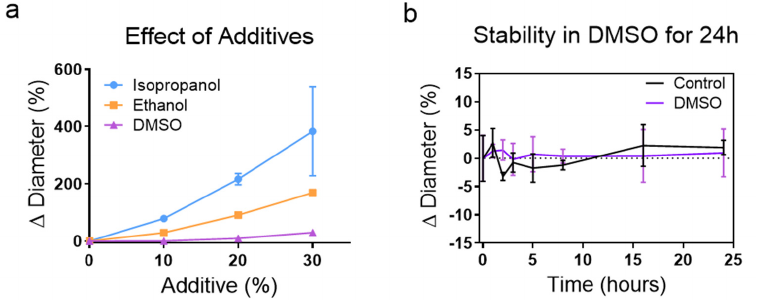
Figure 2. Analyzing the effect of temperature and solvents on liposome stability. ( a ) Liposomes incubated at 55 ◦ C for 1 h with 10% DMSO did not show a statistically significant change in mean diameter ( p = 0.9565). However, higher levels of DMSO and all tested concentrations of IPA and EtOH drastically affected the population. ( b ) Liposomes incubated at 55 ◦ C with and without 10% DMSO were stable for up to 24 h and showed no significant change in liposome diameter.